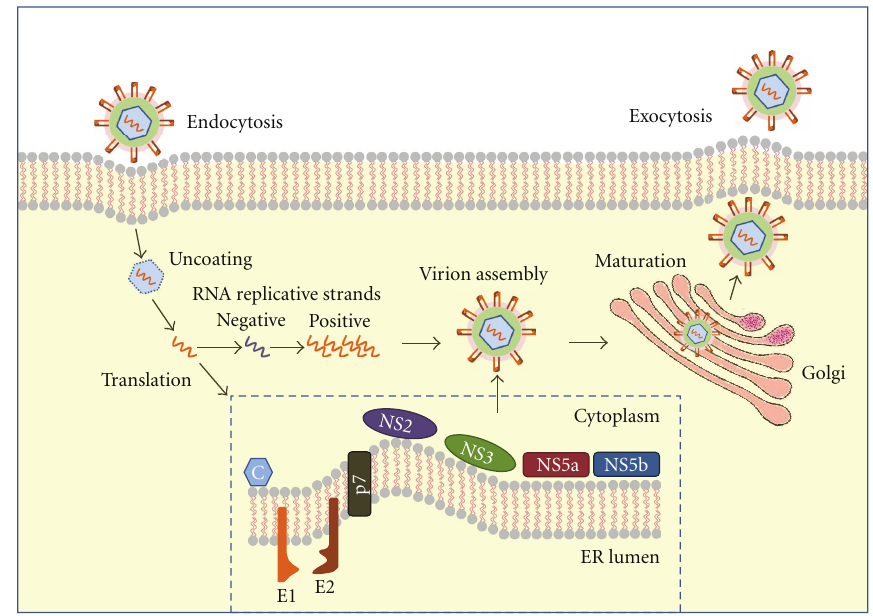
Figure 1: HCV life cycle in host cell. During the replicative stage, after endocytosis, HCV genomic RNA is transcribed into a complementary (negative) RNA strand. After genome amplification and structural and nonstructural viral protein expression, progeny virions are assembled and released.